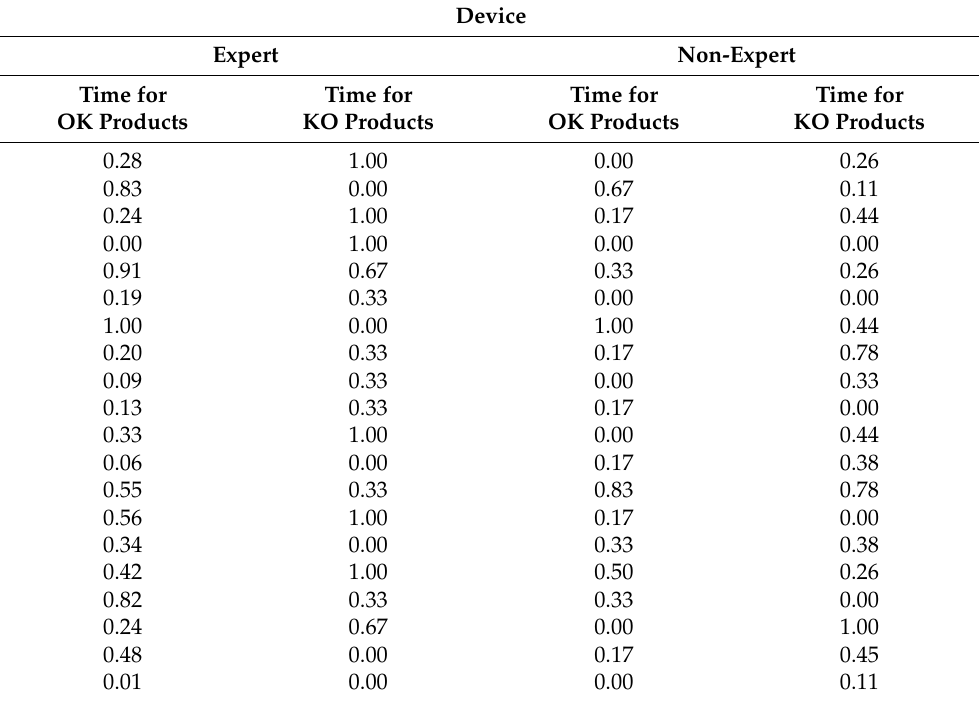
Table 8. Normalized duration of the quality control procedure made by expert and non-expert operators with AR devices, differentiating by compliant (OK) and non-compliant (KO)